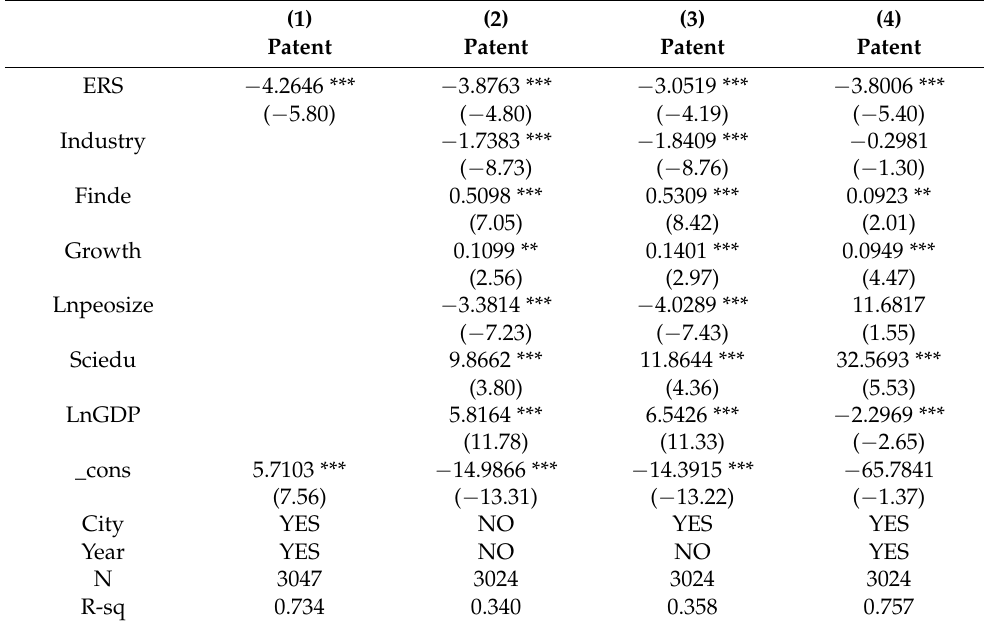
Table 7. Results of robustness tests after replacing the urban innovation